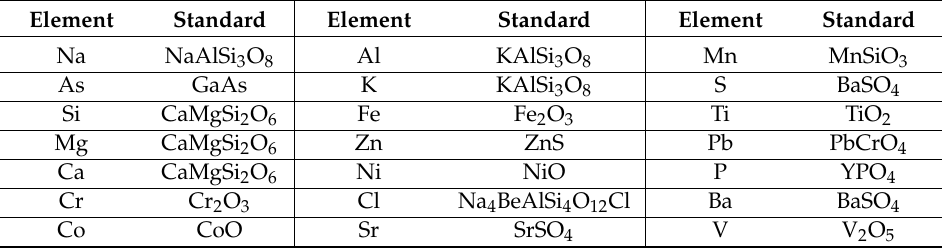
Table 1. Standards used during EPMA